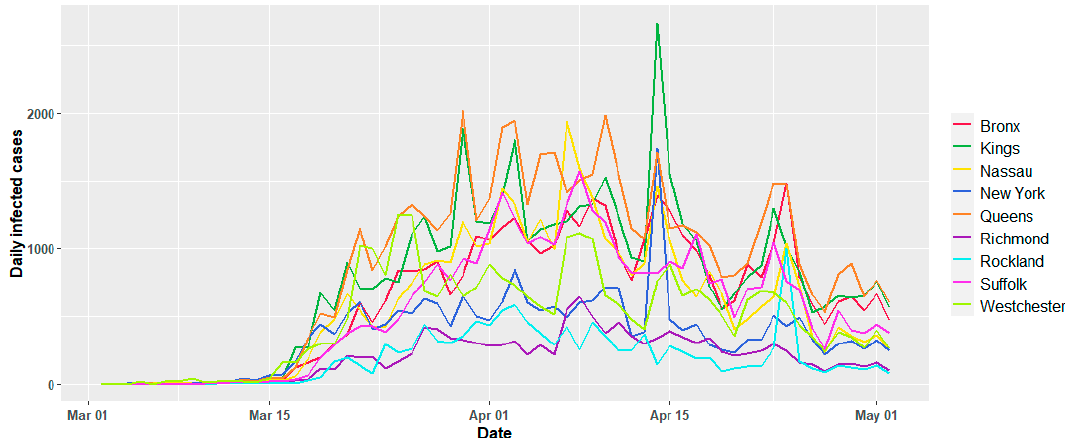
Figure 6. Variation of daily confirmed COVID-19 infected cases for individual counties.